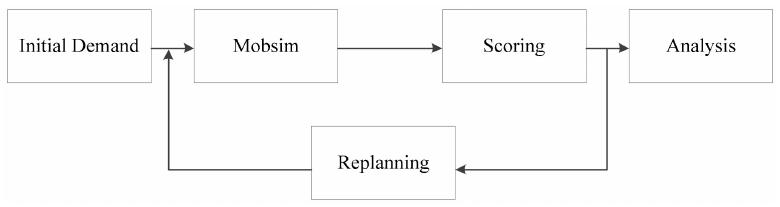
Figure 2. Simulation